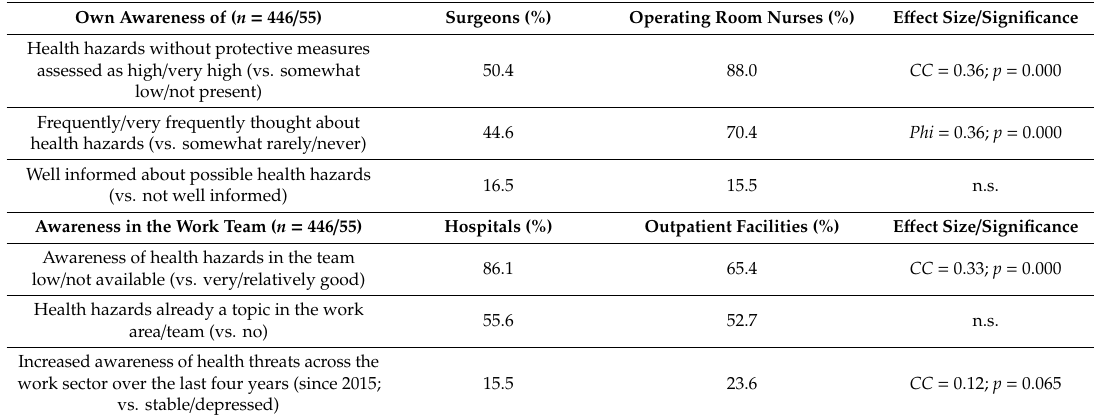
Table 2. Awareness of health hazards caused by surgical